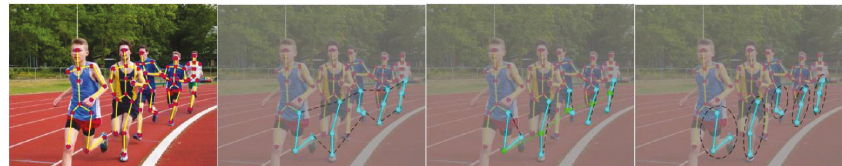
Figure 3: The effect of part affinity fields at different stages.